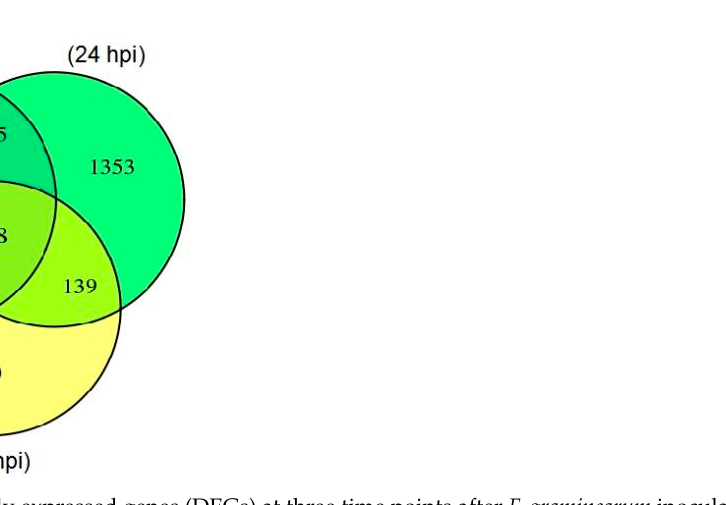
Figure 1. Differentially expressed genes (DEGs) at three time points after F. graminearum inoculation. The number of DEGs were calculated by comparison of samples at 12, 24 and 48 hpi versus the control F. graminearum.